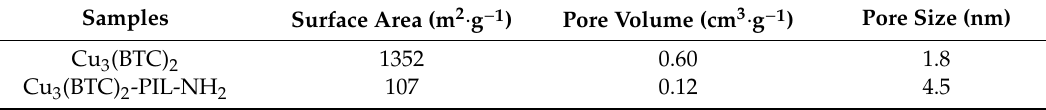
Table 1. The derived porous parameters of Cu 3 (BTC) 2 and Cu 3 (BTC) 2 -PIL-NH 2 .